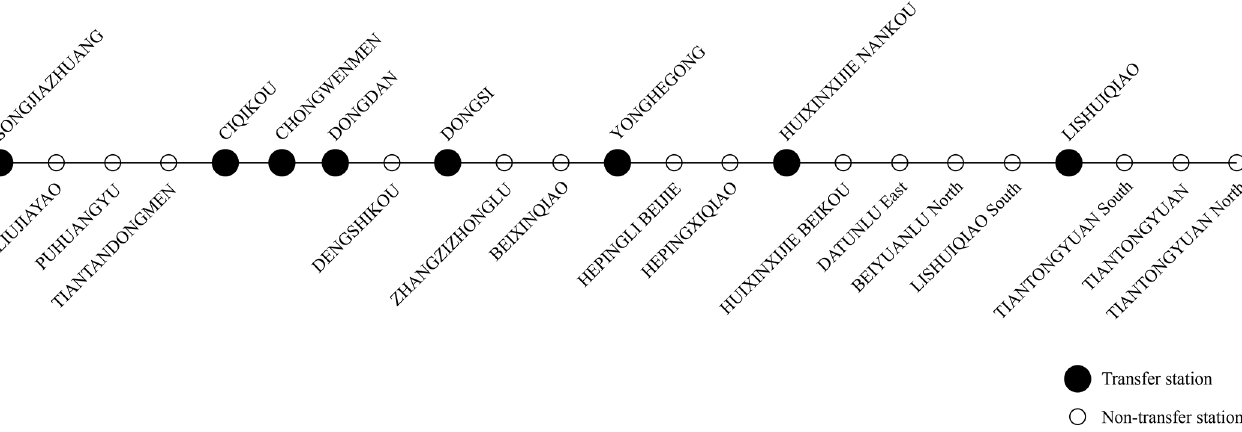
Fig 16. Illustration of Line